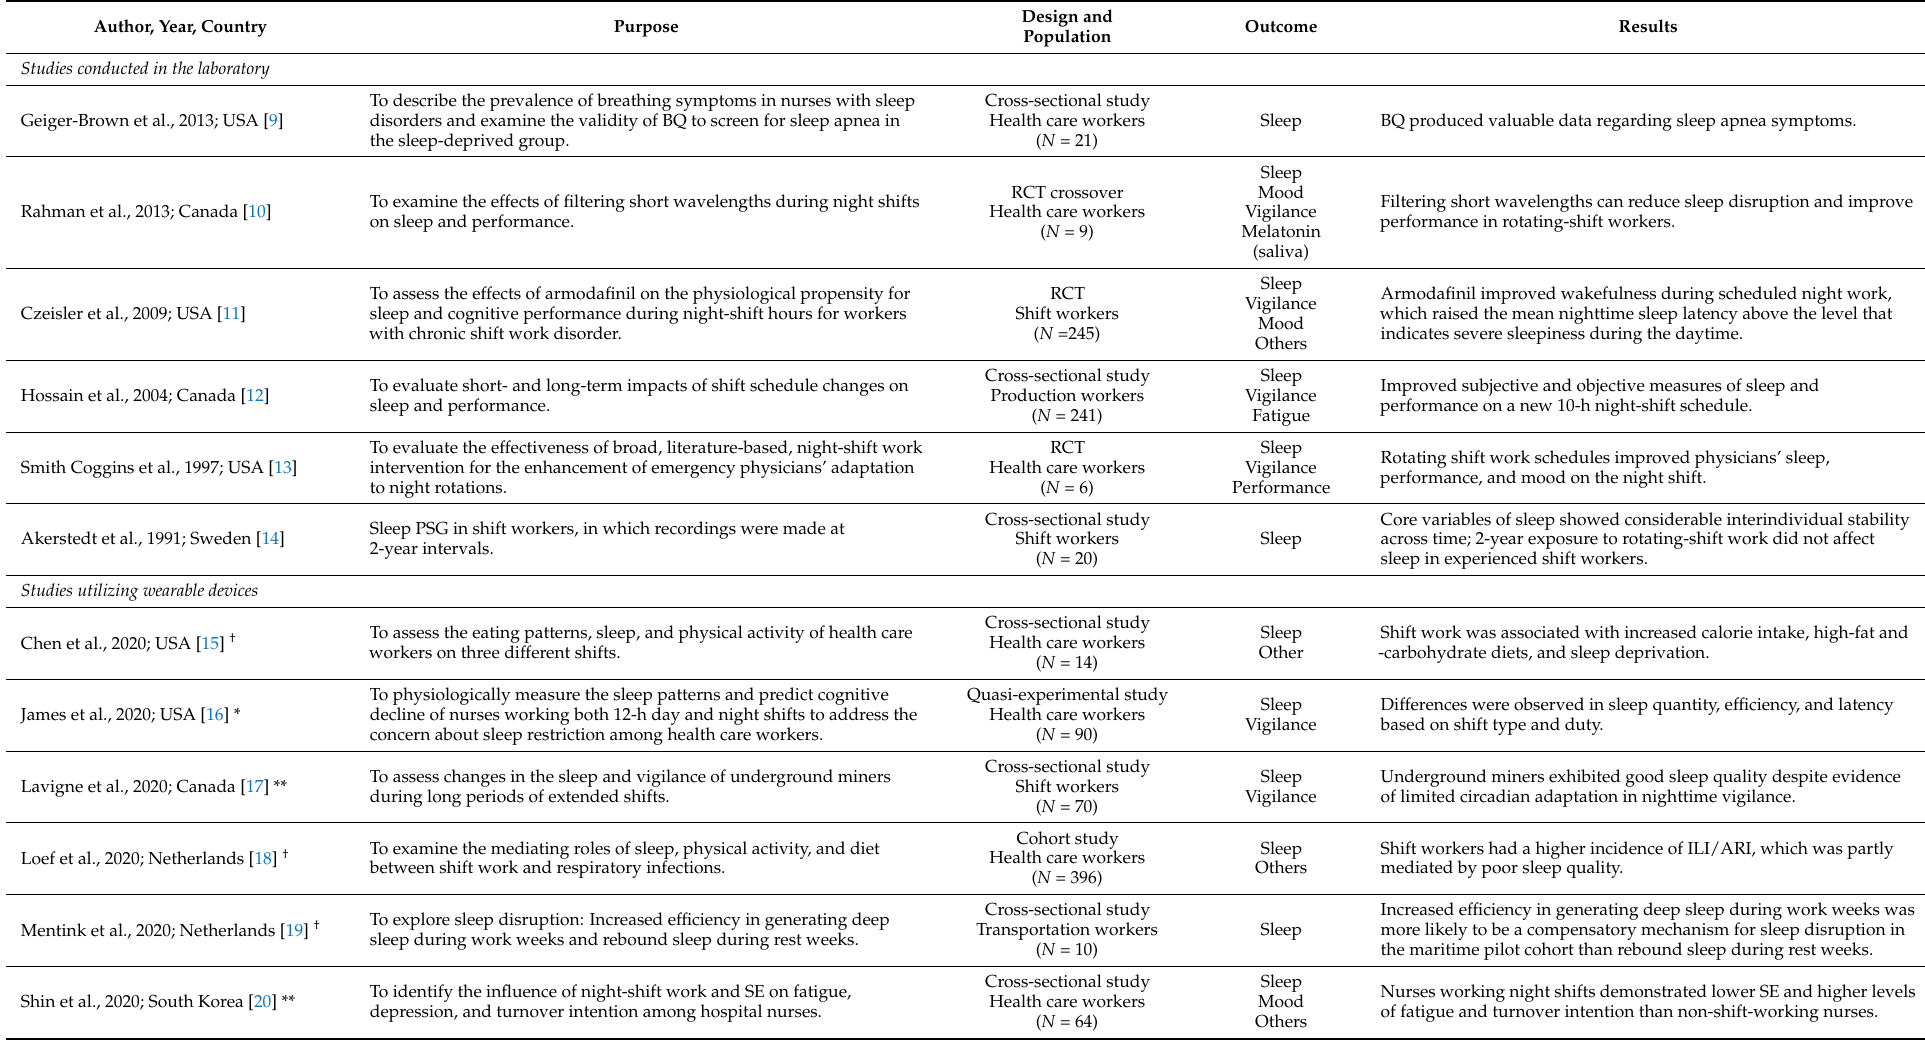
Table 2. Descriptive summary of the included studies ( N =